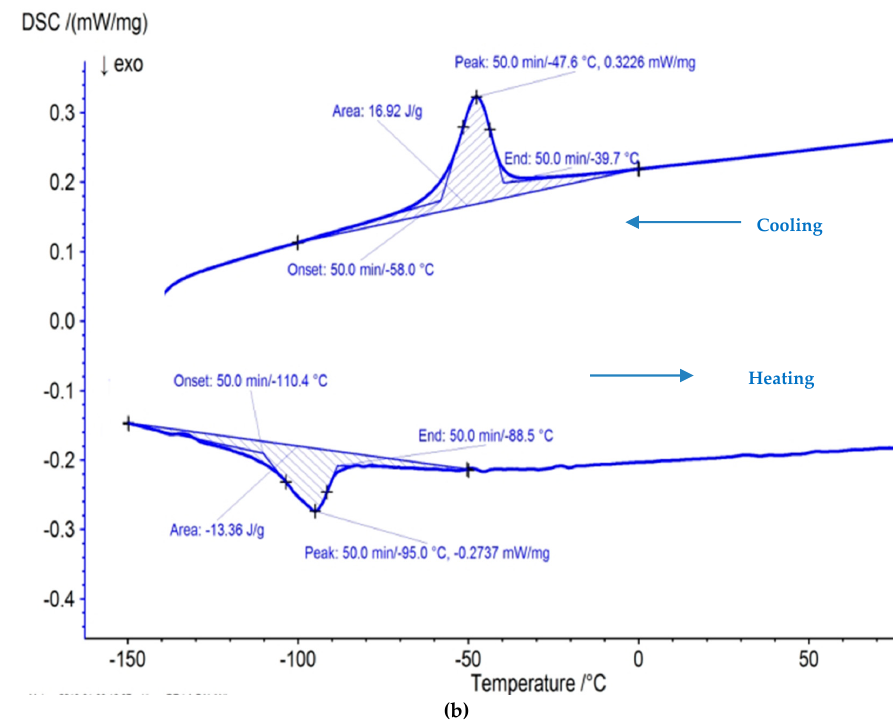
Figure 10. Differential scanning calorimetry (DSC) curve of NiTi alloy for ( a ) unmachined sample ( b ) machined sample at optimized parameter.